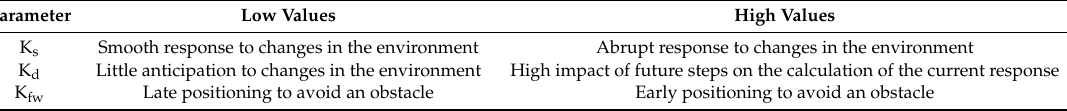
Table 2. Analysis of the e ff ect of the configuration parameters.